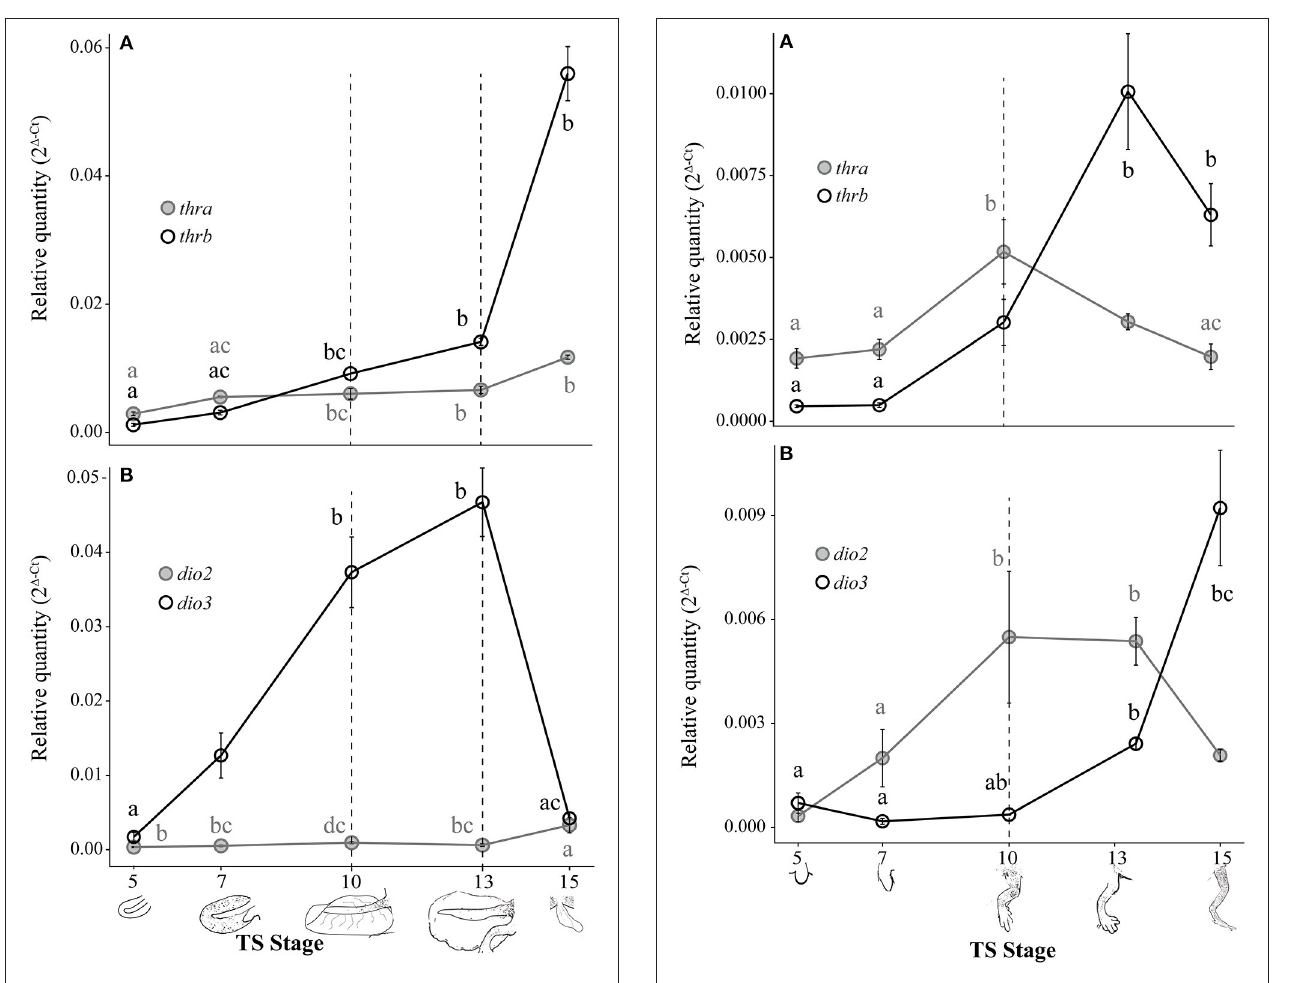
limb development [ Figure 4B ; dio2 : Kruskal-Wallis rank